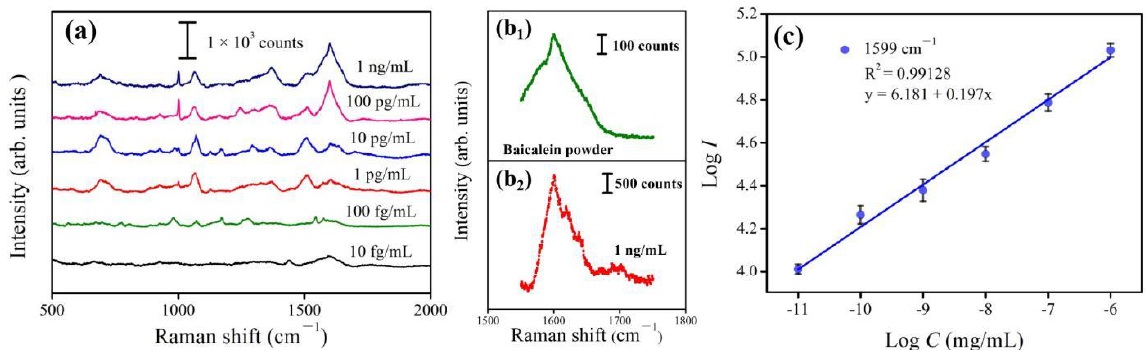
Figure 11. ( a ) Raman spectra of Baicalein at different concentrations ranging from 1 ng/mL to 10 fg/mL; ( b 1 , b 2 ) Raman spectra of Baicalein powder and 1 ng/mL Baicalein; ( c ) corresponding calibration curve of the peak intensity at 1599 cm −1 .